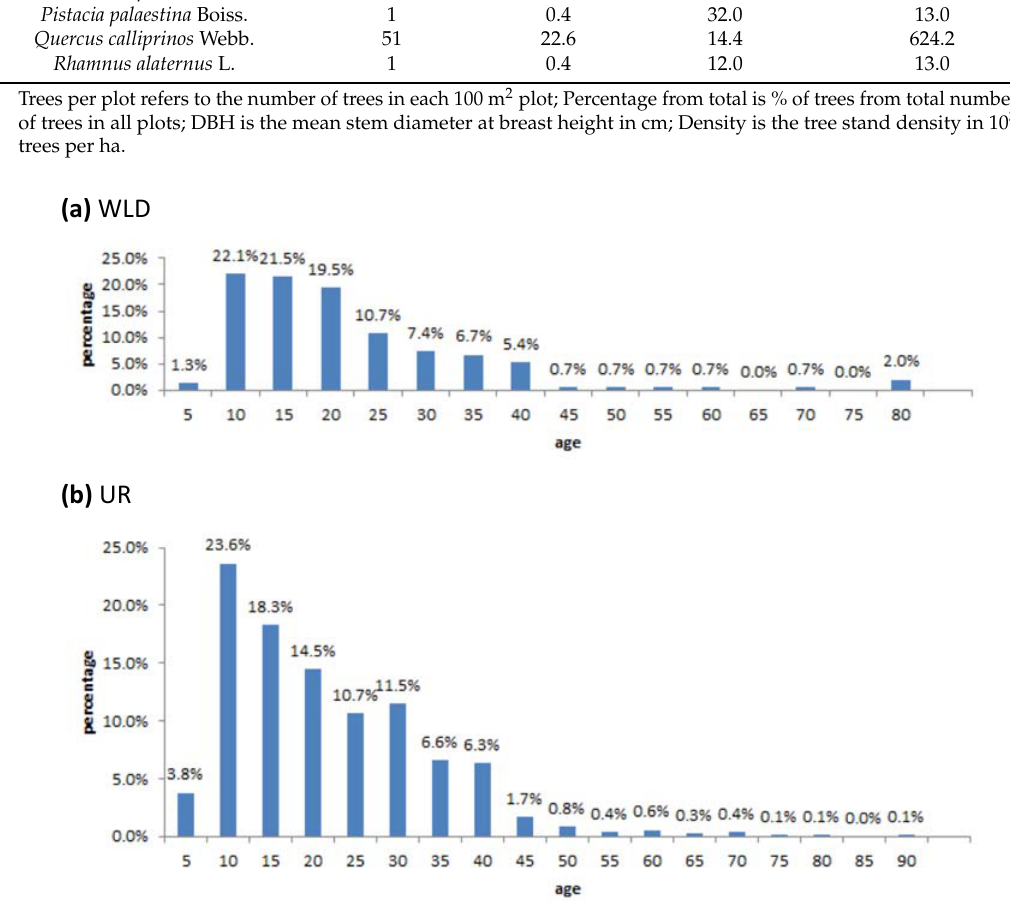
Figure A1. Tree age distribution in ( a ) WLD and ( b ) UR domains.